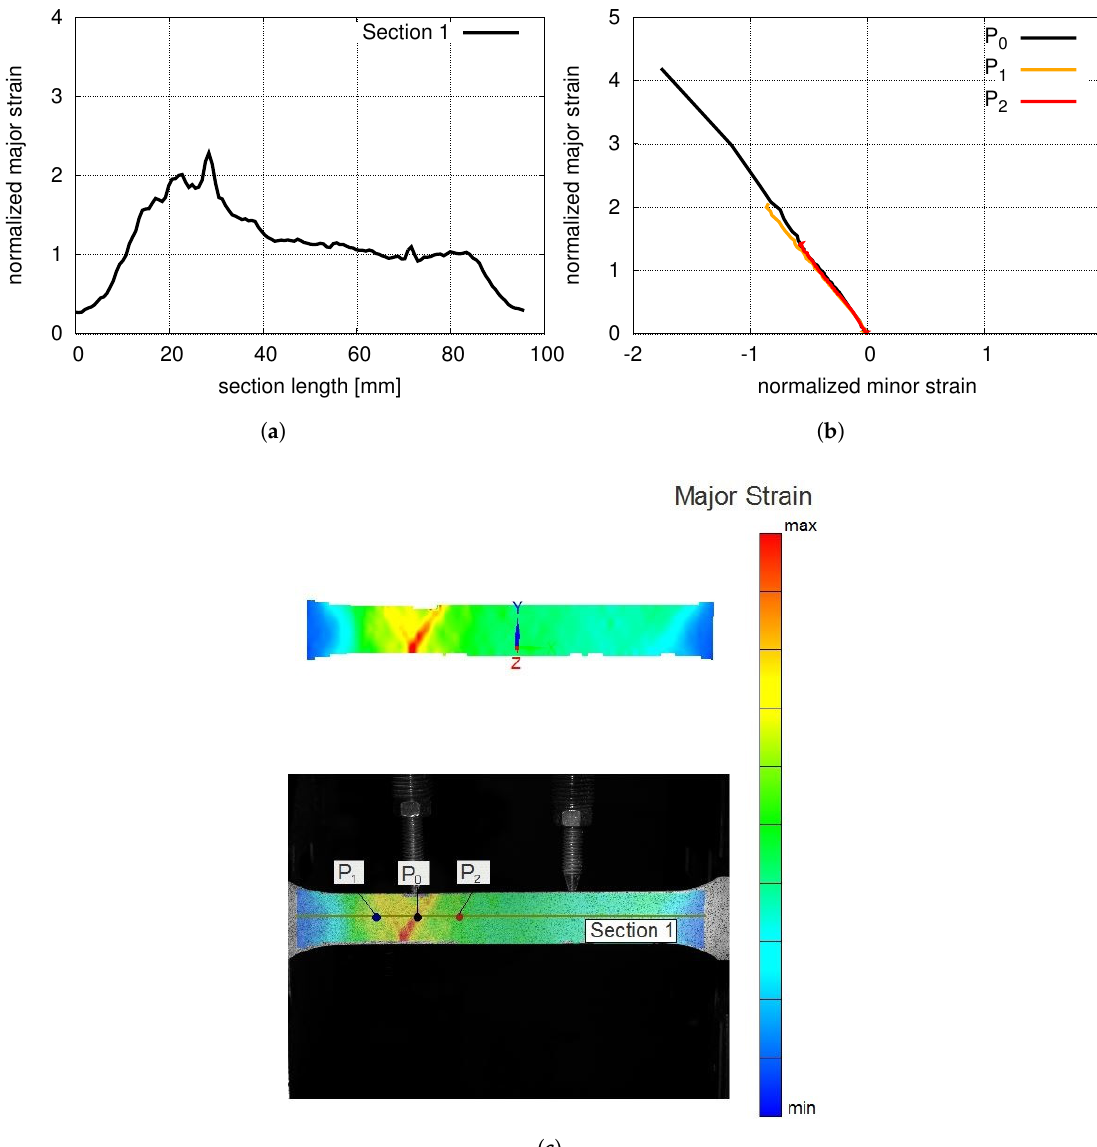
Figure 12. Strain distribution along the specimen length normalized with respect to the mean uniform strain ( a ), experimentally determined strain growth for different points lying on the shear bands and far from them with strains normalized with respect to the mean uniform strain ( b ) and the evolution of shear bands ( c ) in the pre-failure regime of an A50 sample